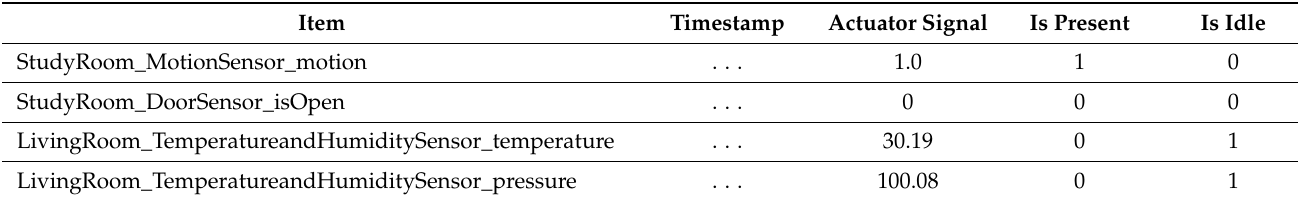
Table 6. Sample action signals to